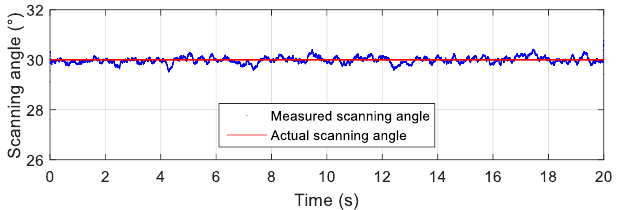
Figure 6. Scanning angle of the simulation based on the geomagnetic field.